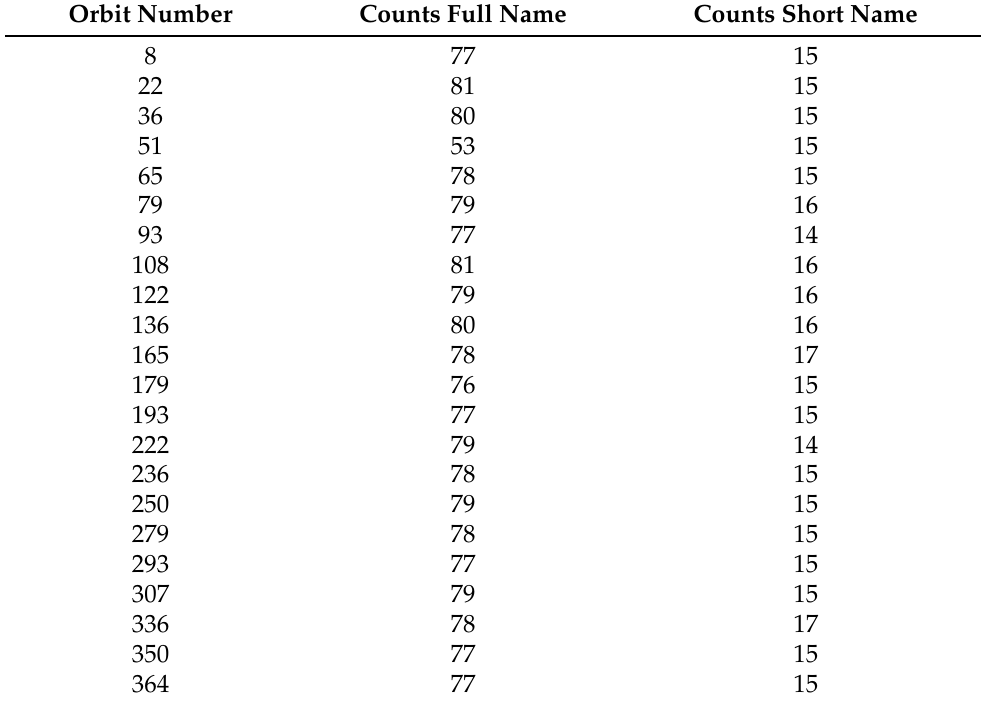
Table 2. Frequent orbits for the NL-Spe